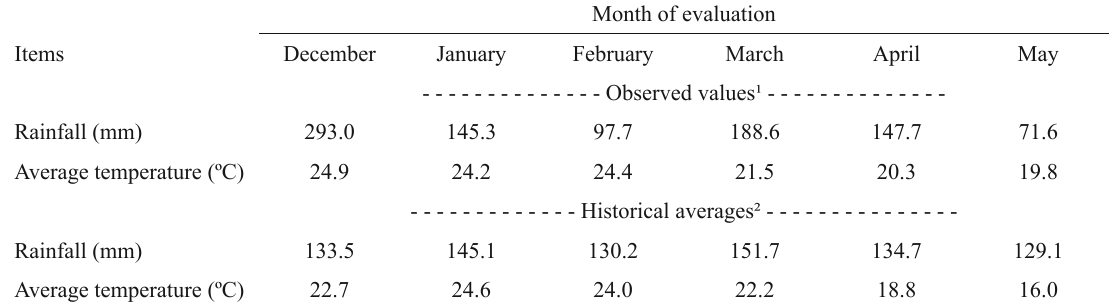
Average monthly temperature and rainfall during the evaluation period and normal history data. Santa Maria/RS. Month of